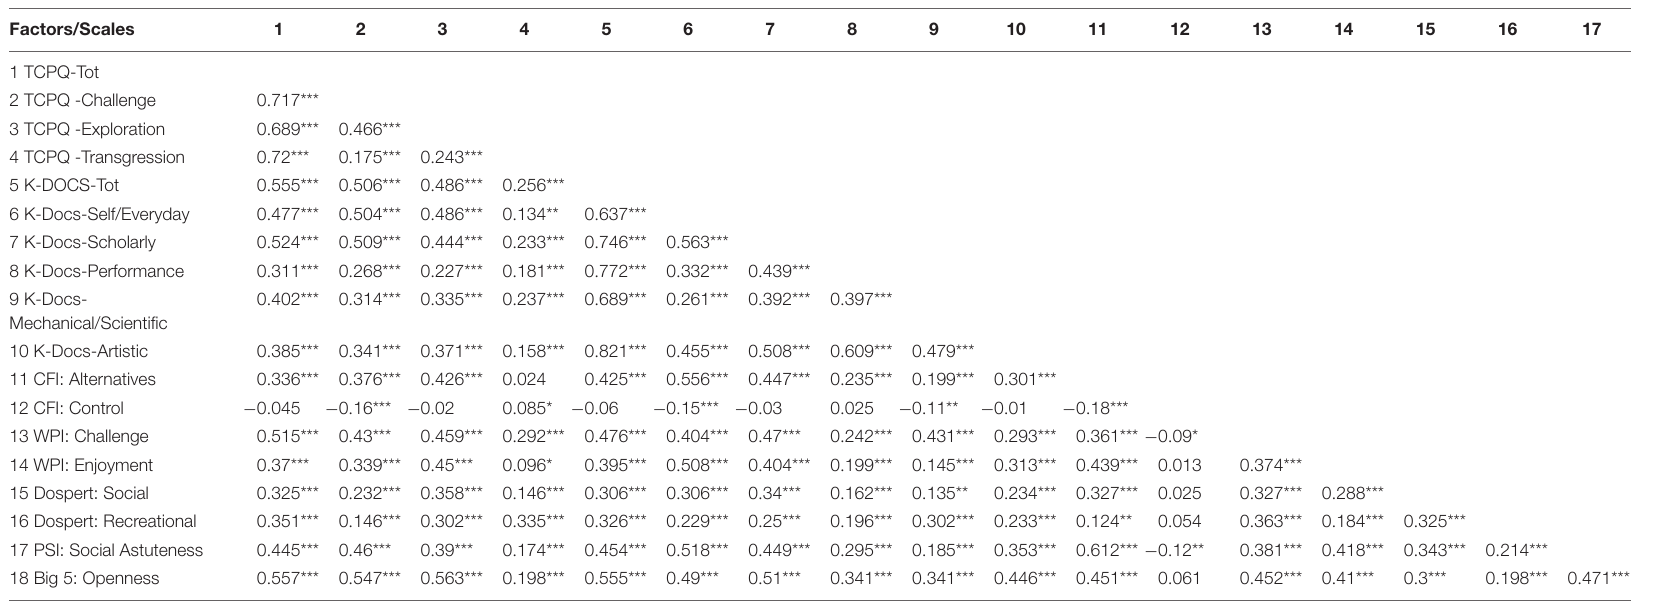
TABLE 3 | Pearson’s correlations amongst tests and